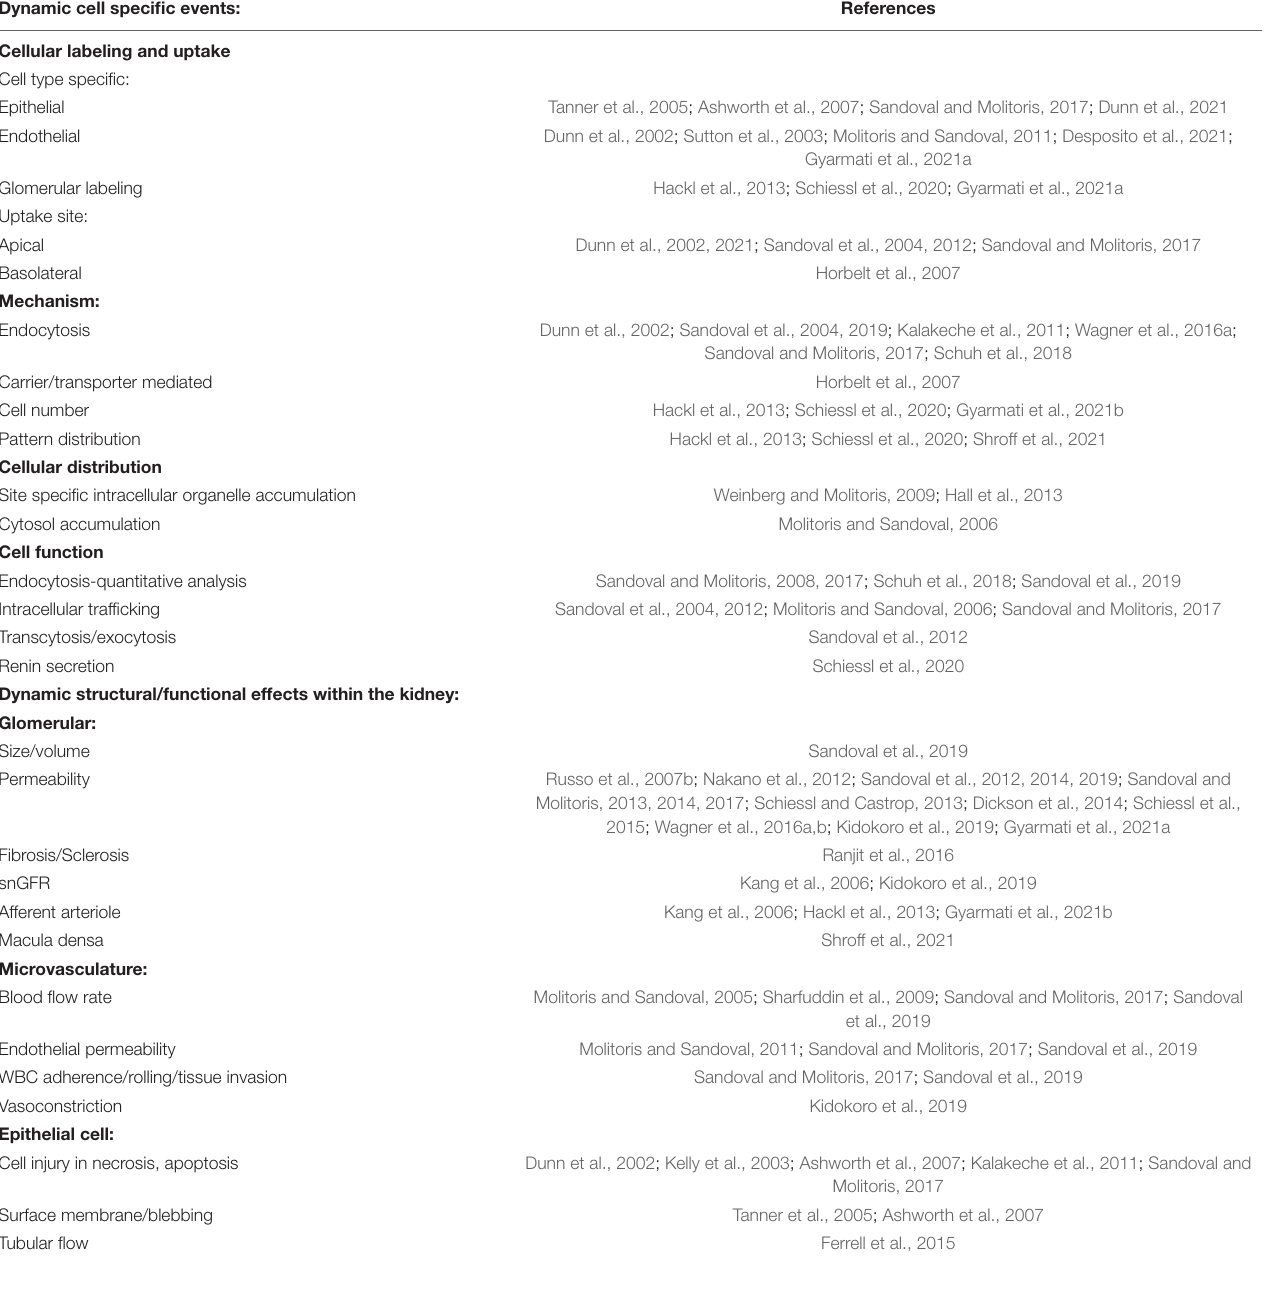
TABLE 1 | Potential uses of multiphoton microscopes in kidney